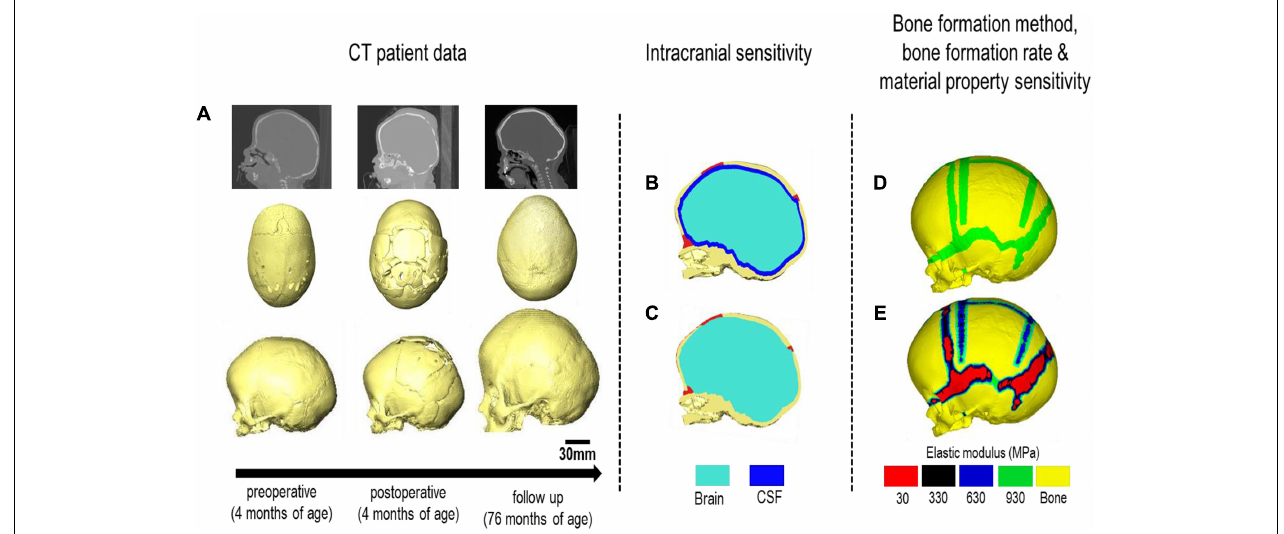
FIGURE 1 | Workflow of the study. CT images of the patient are obtained at various treatment stages. (A) The preoperative CT is used for image processing and 3D reconstruction. Two intracranial volume models (B,C) were then compared under differing bone formation methods (D,E) .